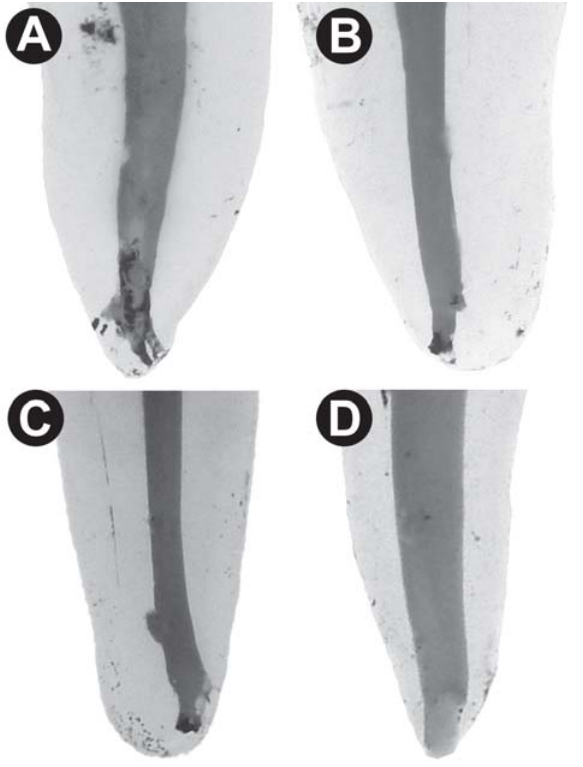
FIGURE 1- Apical region of clarified teeth showing dye penetration. A) EndoFill; B) AH Plus; C) EndoREZ; D) Epiphany